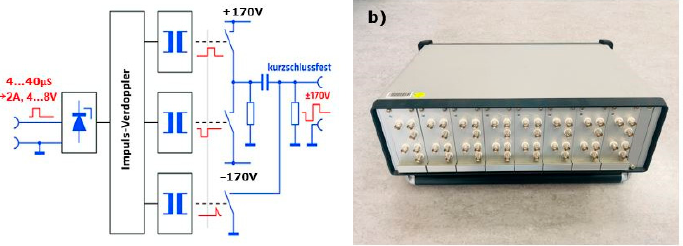
Figure 6. ( a ) Block diagram of single transmission stage, ( b ) Assembly of multi-channel transmit- ter.